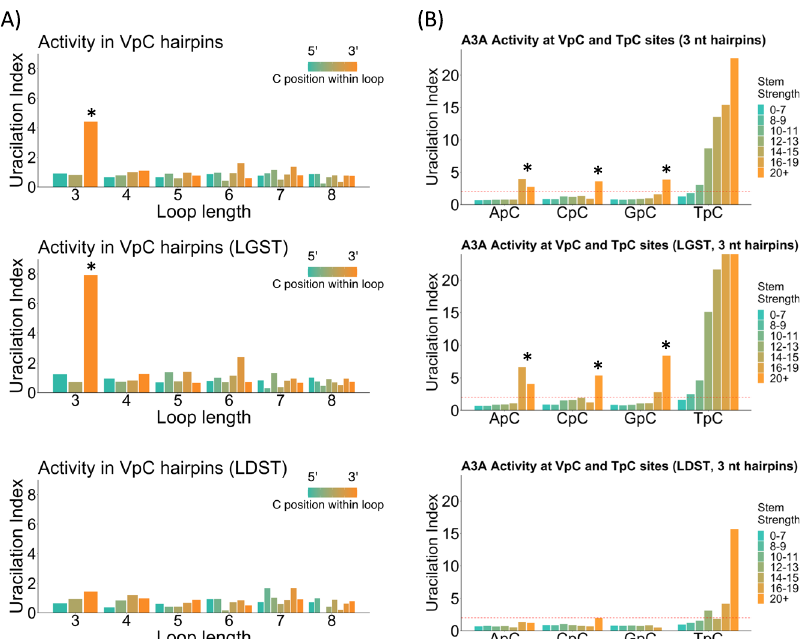
Fig. 4 APOBEC3A can deaminate VpC sites in bacteria. A Relative APOBEC3A activity, measured as Uracilation Index (UI), at cytosines in VpC sequences in predicted hairpin loops in the genome of E. coli . Increased activity is observed at cytosines in NVC triloops (asterisks), but only on the lagging- strand template (LGST). B Comparison of relative APOBEC3A activity in VpC sequences. Increased activity is seen at VpC sites in the loops of strongly paired hairpins (asterisks). Activity at hairpin VpC sites is several times stronger than at non-hairpin TpC sites. Activity at hairpin TpC sites is much higher than comparable VpC sites. Source data are provided as a Source Data fi